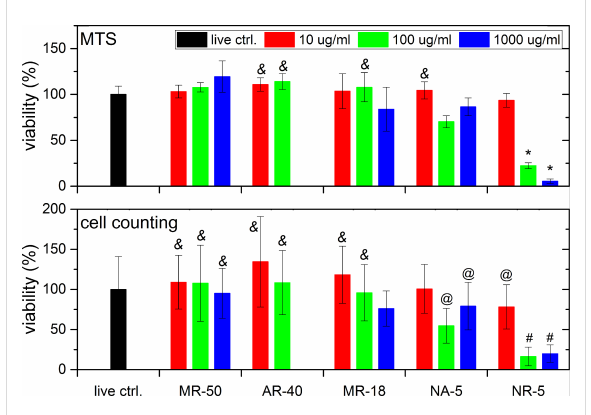
Figure 3: Viability of SAOS-2 cells incubated with NDs at three con- centrations as a function of ND type and surface treatment after 3 days. (Upper row) results of the MTS assay; (lower row) results of cell counting after nuclei staining. The results are given as the mean ± SD from 3 experiments, each performed in sextuplicate. ANOVA, Tukey HSD post-hoc test. “&” - significant difference from NA-5 100 µg/mL ( p < 0.05), “*” - significant difference from all other measurements ( p < 0.01), “#” - significant difference from all other measurements except for NA-5 100 µg/mL ( p < 0.01), “@” - significant difference from MR-50 10 and 100 µg/mL, AR-40 10 µg/mL ( p < 0.05).